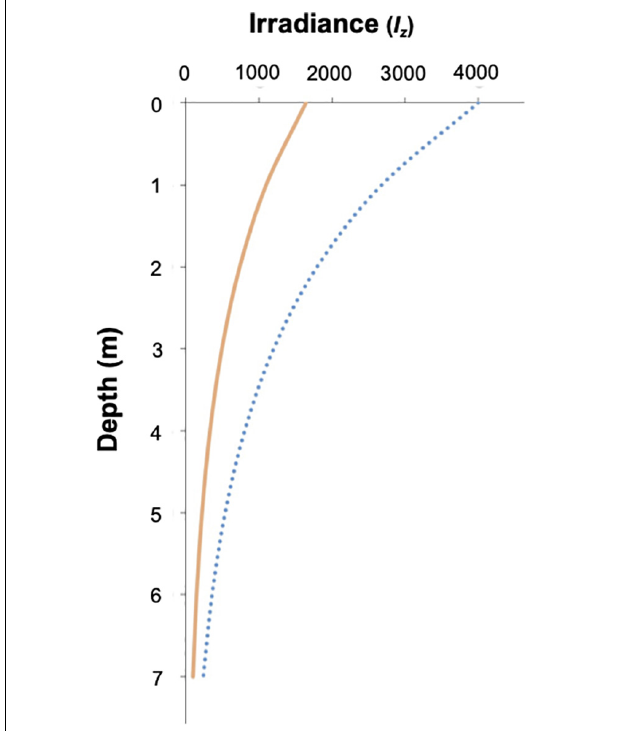
FIGURE 9 | Relative light intensity as function of depth in the Mar Menor coastal lagoon. Blue line represents light intensity reaching the jellyfish body and orange line is the light intensity reaching the symbiont living withing the jellyfish